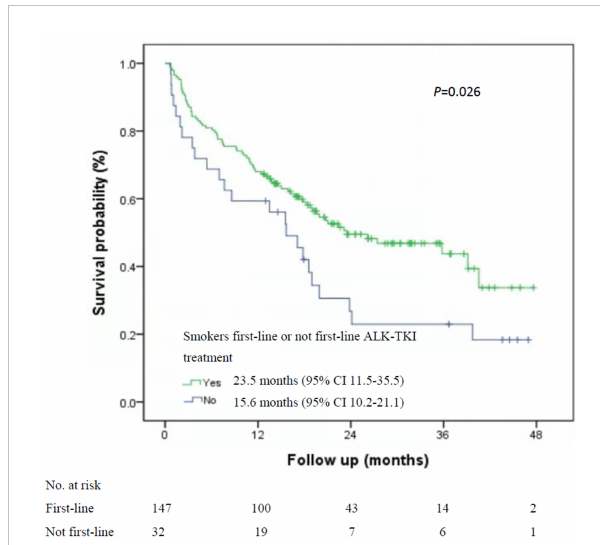
FIGURE 1 Kaplan-Meier curves of overall survival by smoking status among the 535 patients with fi rst-line ALK-TKI treatment. ALK-TKI, anaplastic lymphoma kinase tyrosine kinase